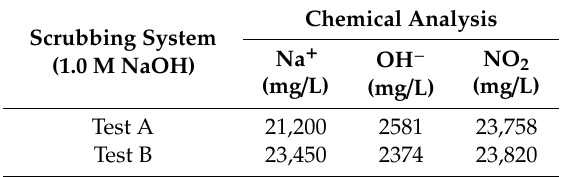
Table 8. Chemical analysis of nitrogen oxide scrubbing tests.